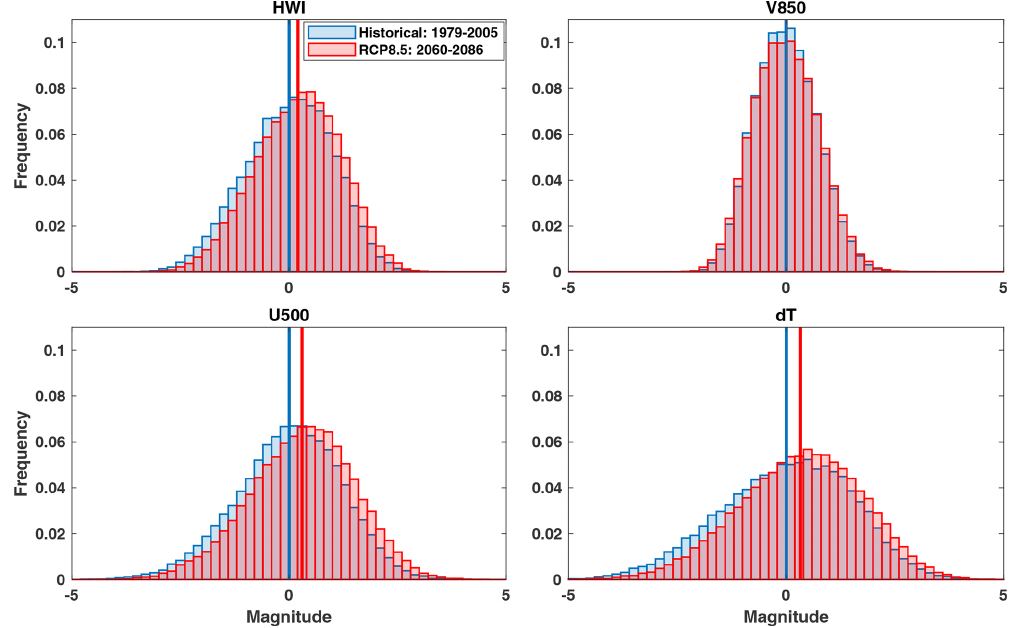
Figure 8. Probability distribution functions (PDFs) for the winter HWI, meridional winds at the 850hPa pressure level ( V 850 ), zonal winds at the 500hPa pressure level ( U 500 ), and temperature gradient between the lower and upper troposphere (d T ). The PDF for the HWI was created using the daily DJF time series of all 16 PPE members. The PDFs for V 850 , U 500 , and d T were created using the normalized daily DJF time series of each variable calculated for the HWI (see Sect. 2.2 for details) and represent the constituent variables of the HWI. Blue bars show the PDFs for the historical period and red bars show the PDFs for the far future under the RCP 8.5 scenario. Solid blue and solid red lines show the mean values of the PDF for the historical and far-future periods,